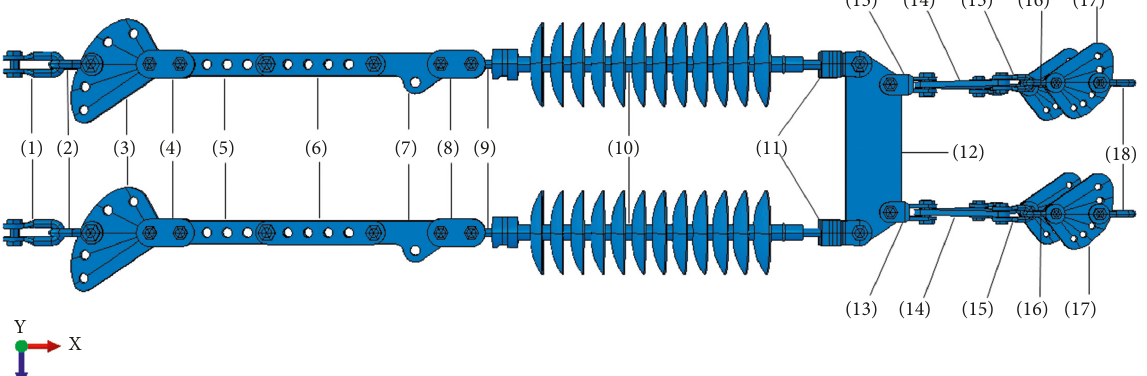
Figure 17: Integral model of tension string.